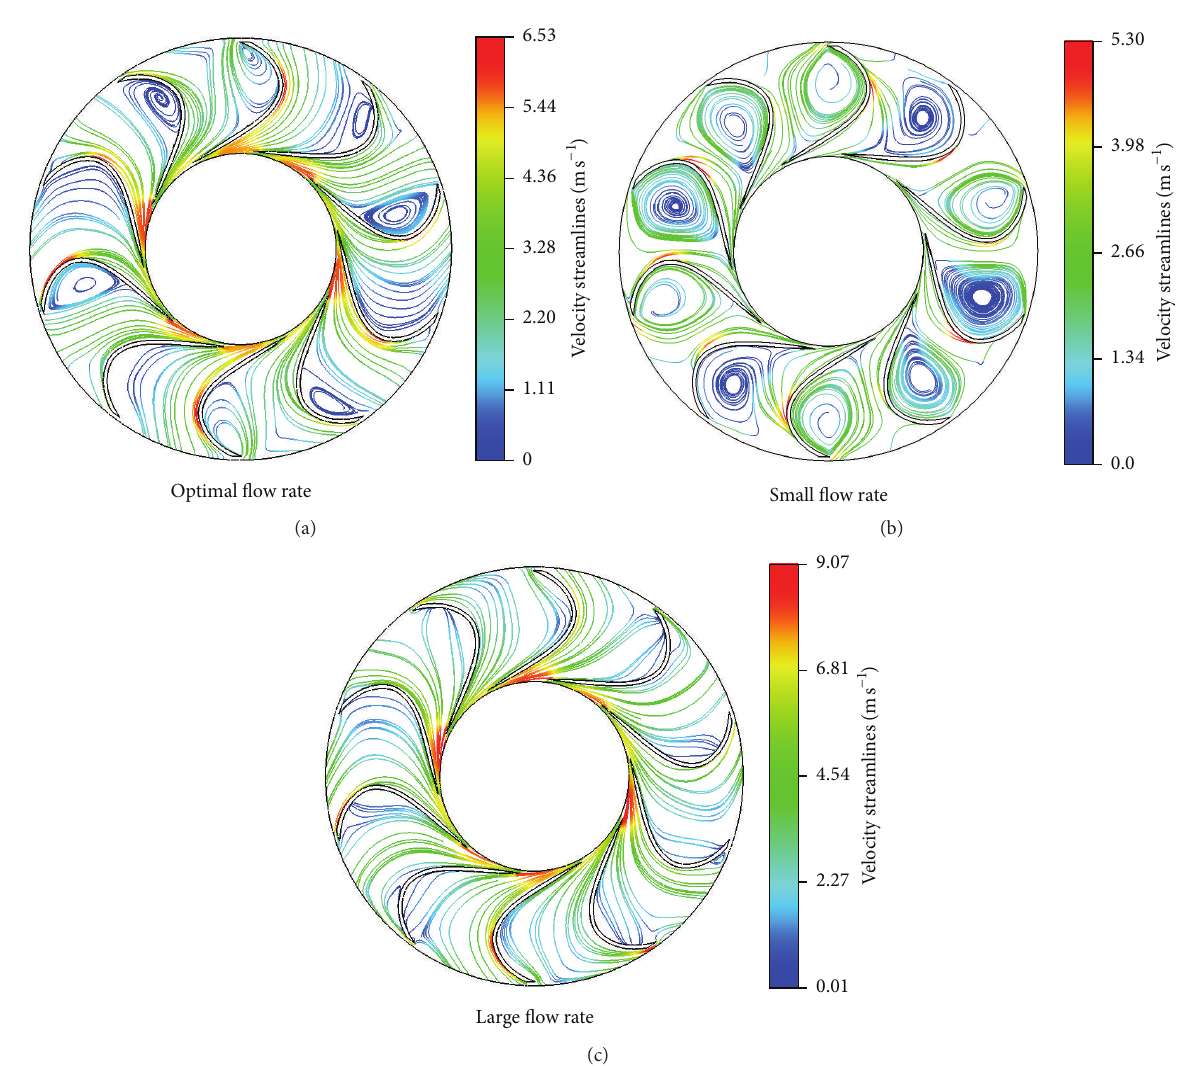
Figure 11: Streamlines in the runner at midspan: (a) optimal BEP, (b) low flow rate, and (c) large flow